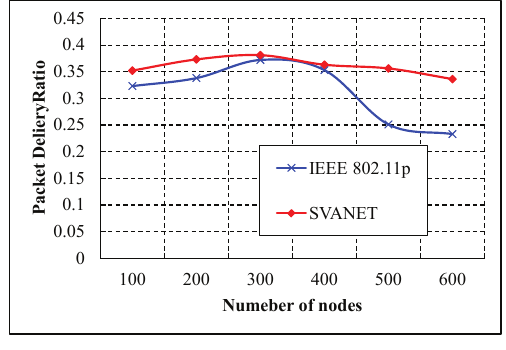
Figure 20. Average packet delivery ratios in the highway with six lanes.